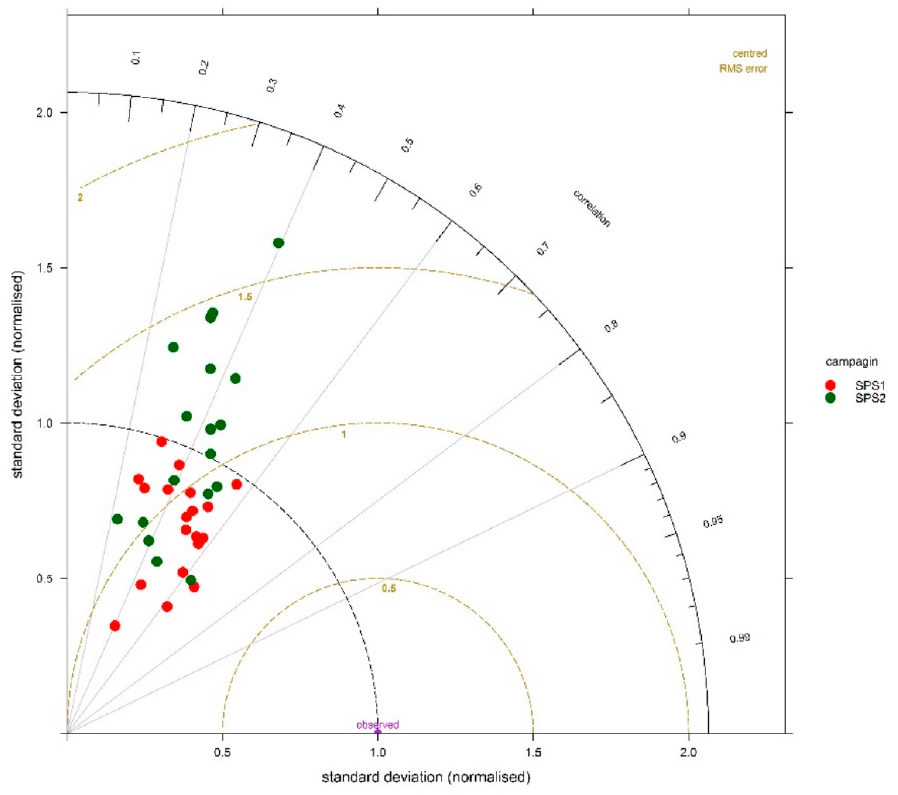
Figure 12. Tayler diagram of hourly NO 2 for all predicted/observed pairs of values at 18 OEH stations for SPS1 (red dot) and SPS2 (green dot).